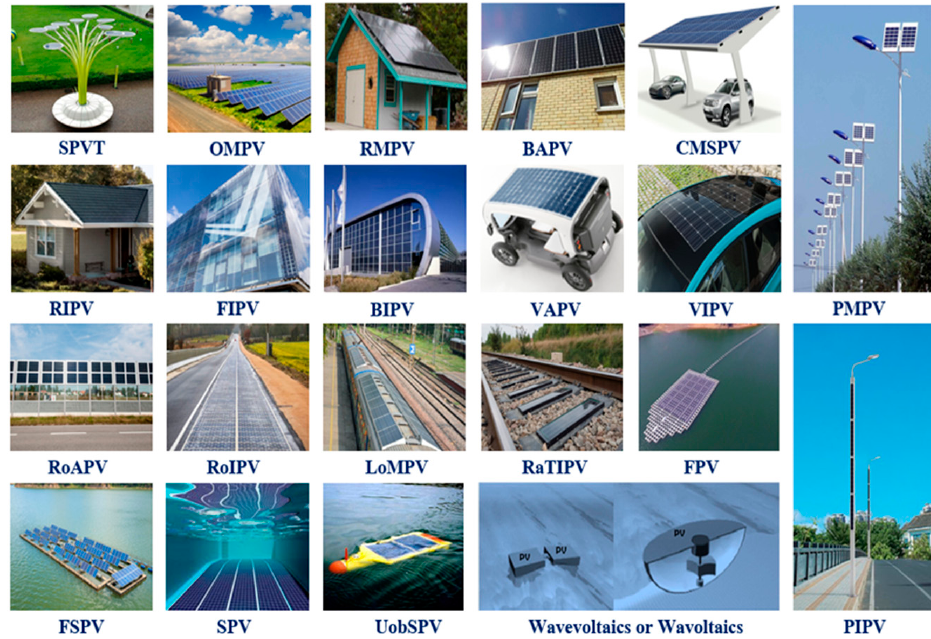
Figure 1. Visual representation of different types of solar photovoltaic plants based on the installation and mounting area. SPVT = solar photovoltaic tree; OMPV = open-mount photovoltaics; RMPV = roof-mount photovoltaics; BAPV = building attached photovoltaics; CMSPV = canopy-mounted solar photovoltaics; RIPV = roof-integrated photovoltaics; FIPV = façade-integrated photovoltaics; BIPV = building-integrated photovoltaics; VAPV = vehicle attached photovoltaics; VIPV = vehicle-integrated photovoltaics; RoAPV = road-attached photovoltaics; RoIPV = road-integrated photovoltaics; LoMPV = locomotive-mount photovoltaics; RaTIPV = rail track integrated photovoltaics; FPV = floating photovoltaics or floatovoltaics; FSPV = floating solar photovoltaics; SPV = submerged photovoltaics; UobSPV = underwater on-board solar photovoltaics; PMPV = pole mounted-photovoltaics; PIPV = pole-integrated photovoltaics.